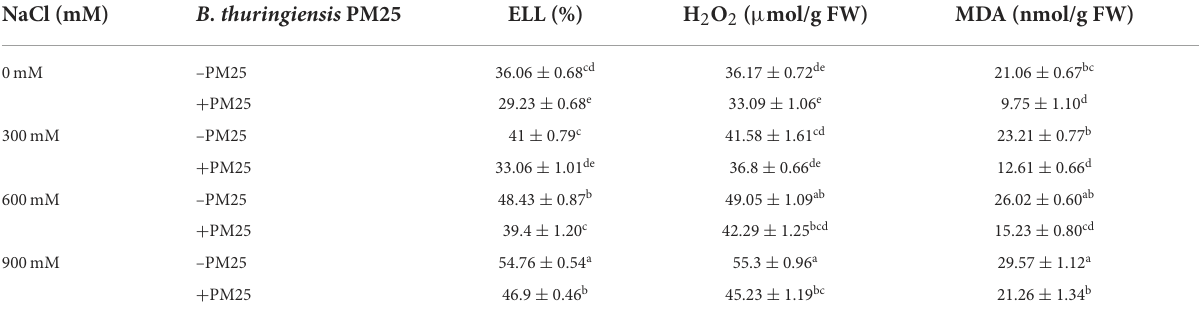
TABLE 5 Level of oxidative stress markers in the presence and absence of Bacillus thuringiensis PM25 under salinity